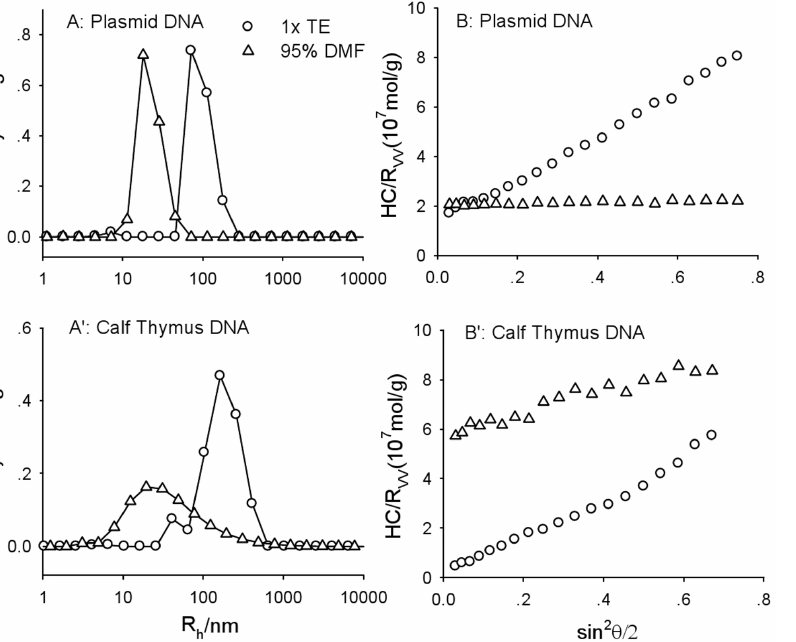
Figure 4. LLS studies on plasmid DNA (A: size distribution at 30 u , B: angular dependence of excess scattered intensity) and calf thymus DNA (A’: size distribution at 30 u , B’: angular dependence of excess scattered intensity). C=1.6 6 10 2 5 g/ml.